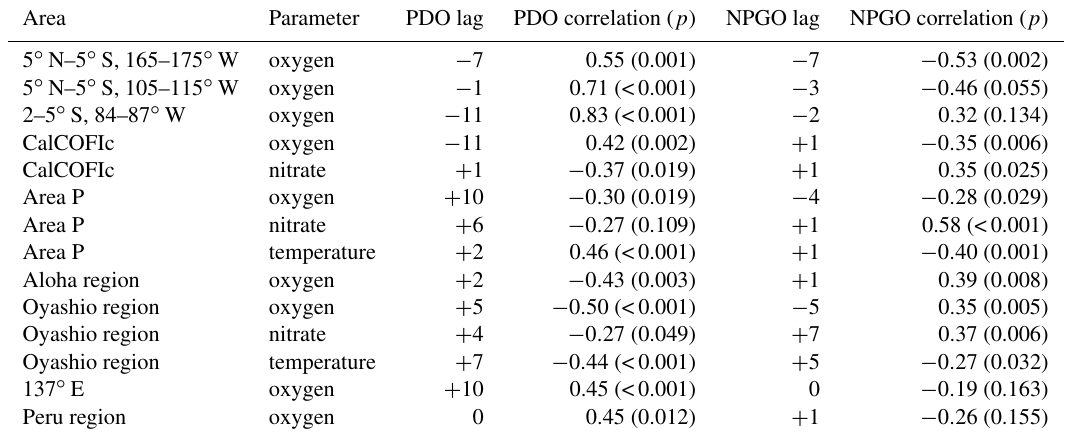
(Fig. 6a; Table 2) and − 0 . 37 ( p = 0 . 019) for nitrate (Table